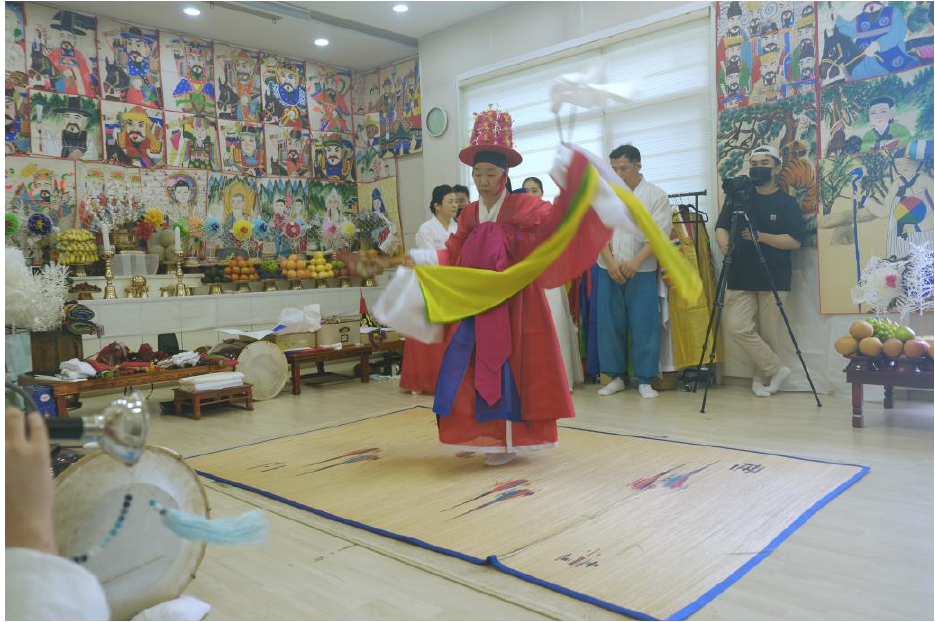
Figure 1. Mudang Yi Hae-gyŏng performing a kut ritual while being filmed by a documentary film production team. July 2022, the photograph was taken by the author with consent from the people depicted.